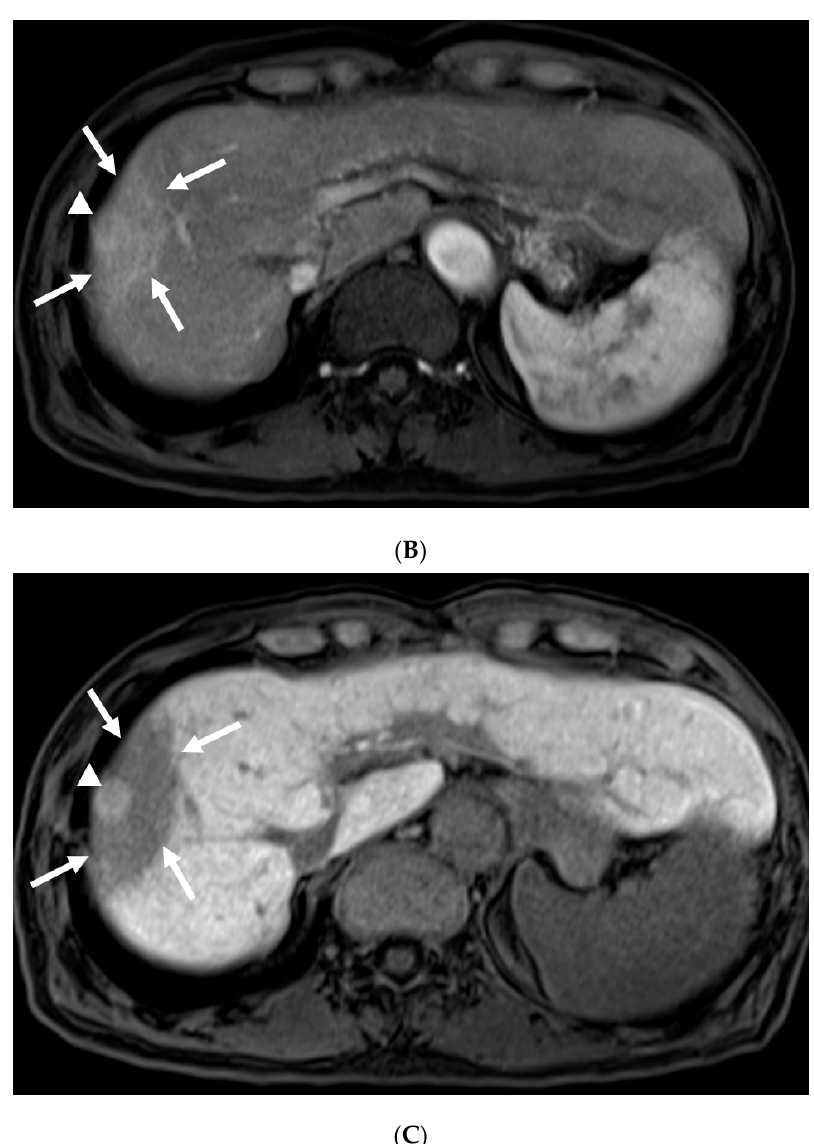
Figure 1. Gadolinium-ethoxybenzyl-diethylenetriamine pentaacetic acid enhanced magnetic reso- nance imaging (EOB-MRI) in a patient (Case 1) at 4.0 months after stereotactic body radiotherapy (SBRT). ( A ) Unenhanced T1 weighted MRI. Unenhanced T1 weighted MRI shows low signal for irradiated area. Focal liver reaction (FLR; arrows) and HCC (arrow head). ( B ) Arterial phase of EOB-MRI. Arterial phase of EOB-MRI shows hyper-enhancement as FLR (arrows) and HCC (arrow head), which means viability of HCC. ( C ) Hepatocyte phase of EOB-MRI. FLR (arrows) show low signal around HCC (arrow head), which is high signal in the hepatocyte phase of EOB-MRI.